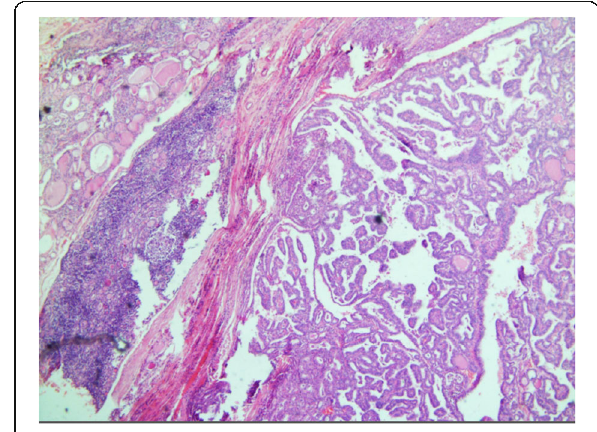
Fig. 1 Papillary thyroid carcinoma (right) on background of lymphocytic thyroiditis (left) (H&E ×